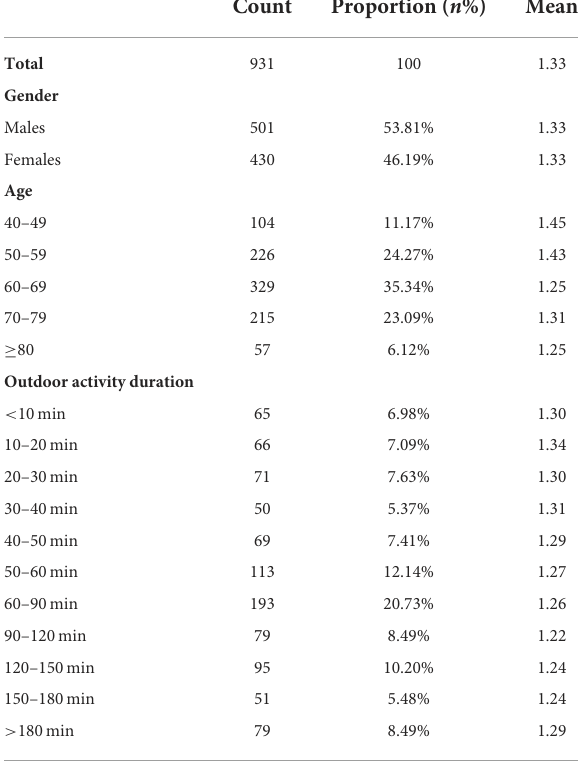
FIGURE4 Sample temperature